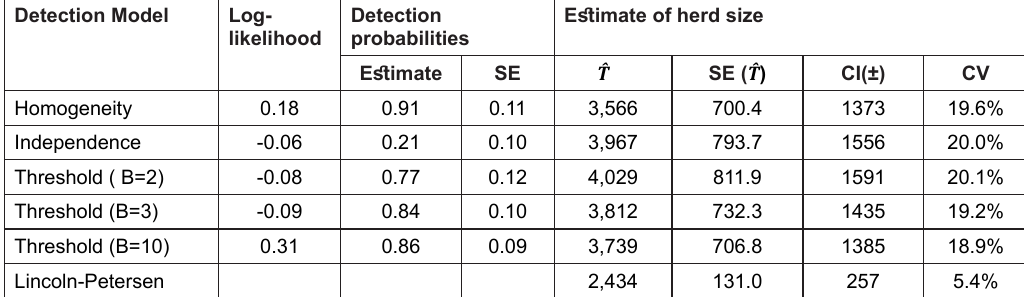
Table 23. Rivest estimator results and LP estimate for Cape Bathurst 2005